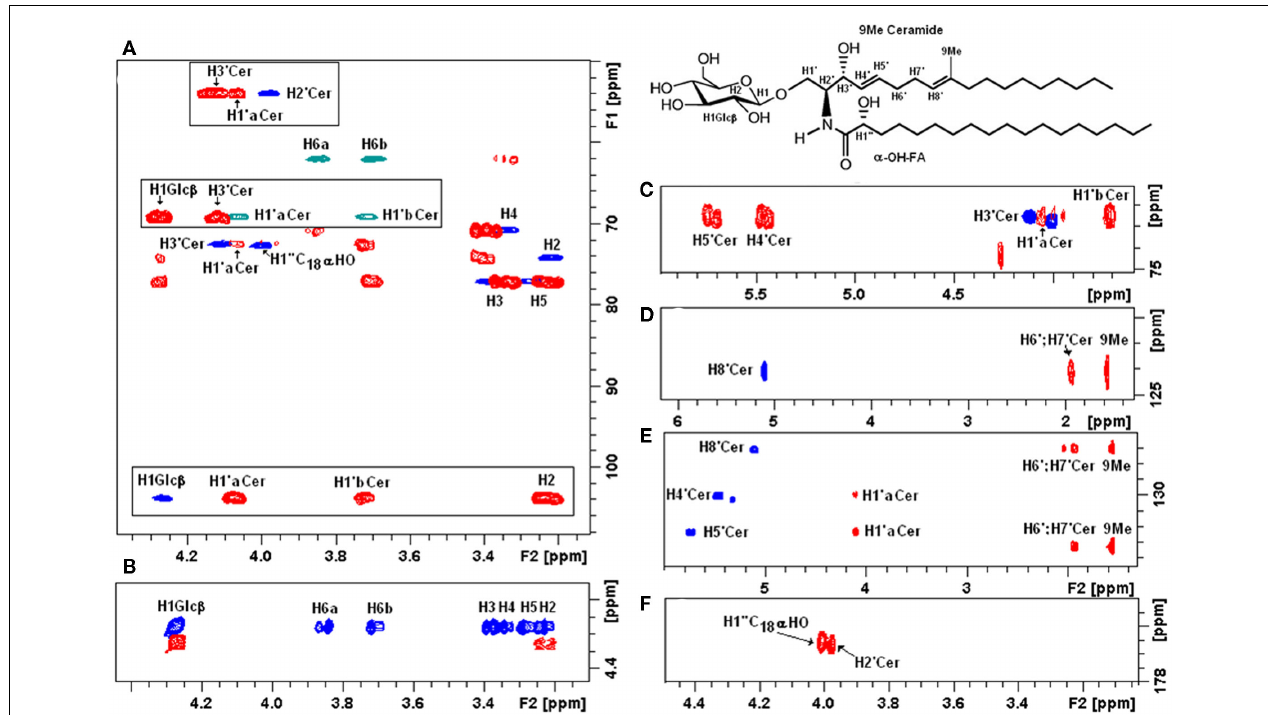
TOCSY (blue) and COZY (red) spectra from the anomeric region showing the main cross peaks of the carbohydrate ring, observation of the total 1 H– 11 H axial correlations and reach the monosaccharide composition. (C–E) HSQC and HMBC slices of unsaturated carbons in ceramide moiety. (E,F) Fingerprint slices of the quaternary carbons (C-9) and amide linkage at 136.4 and 176.5ppm,